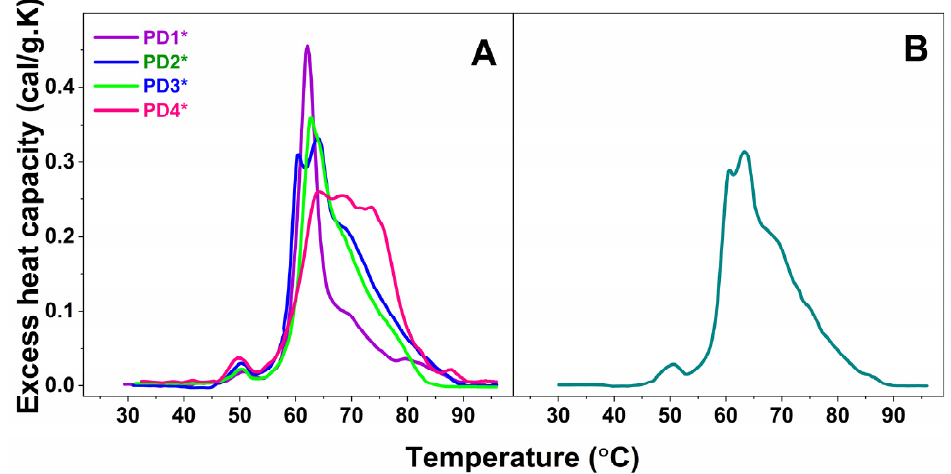
Figure 2. Calorimetric profiles of blood plasma for four not-classified PD cases, denoted PD1*—PD4* ( A ), and one ALS case, denoted ALS* ( B ). Table 1. Thermodynamic parameters (transition temperature, T m ( ◦ C) and amplitude, c Pex (cal/g.K) of the successive thermal transitions (T mFg , T mSh1 , T mHSA , T mIgs , T mSh2 , T mTf&IgG ) and the ratios of the excess heat capacities of T mHSA and T mIgs transitions (c PHSA /c PIgs ) for healthy, PD, and ALS plasma. The number of cases included in each calorimetric set are given in parenthesis.